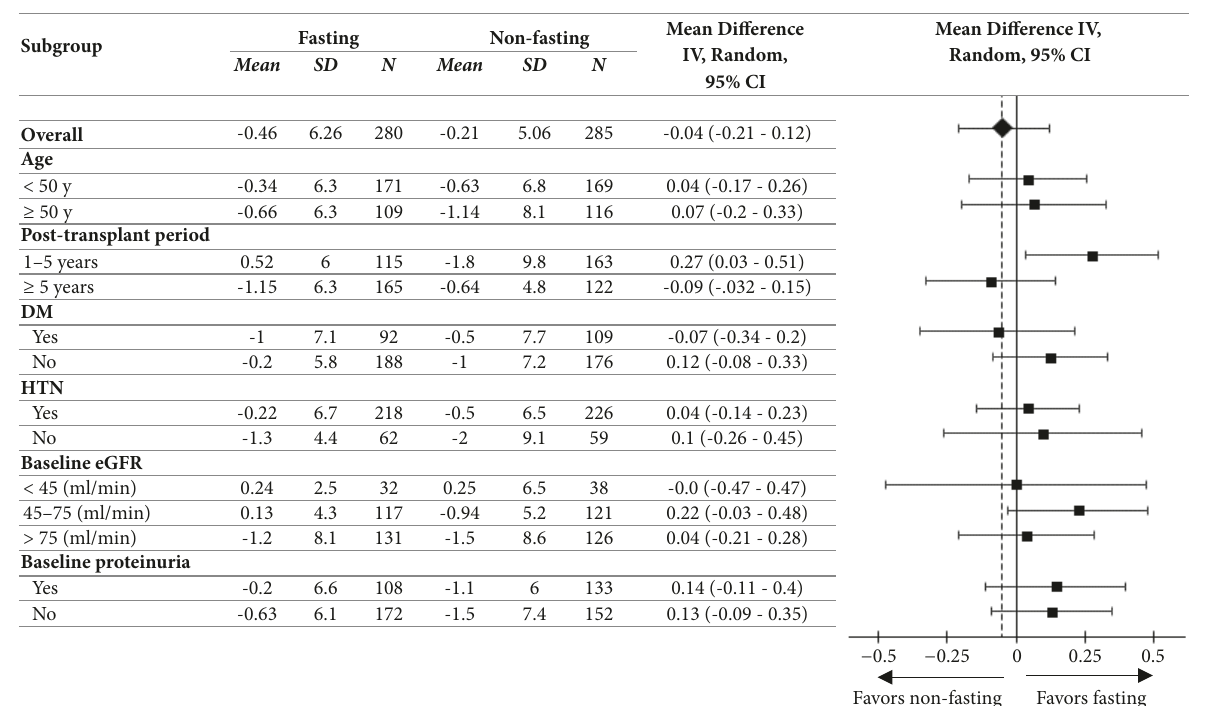
Figure 2: Forest Plot of Primary Outcome According to Subgroups. The dashed vertical line represents the mean difference for the overall study